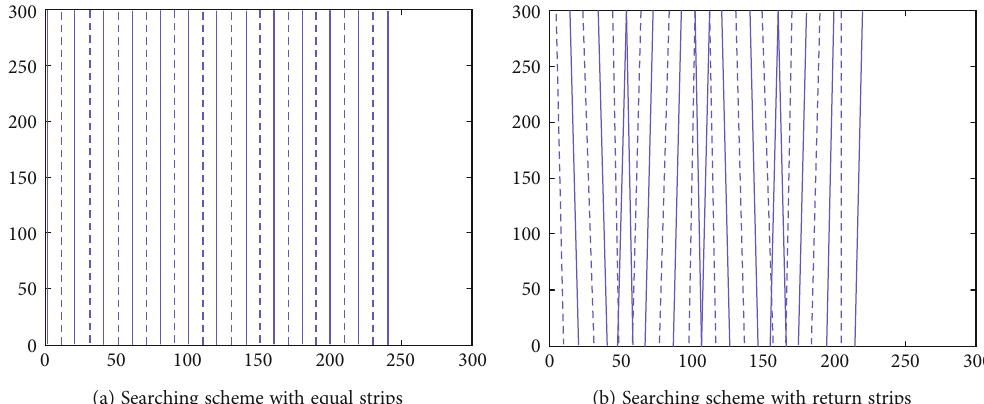
Figure 9: Di ff erent search strategies scheme.